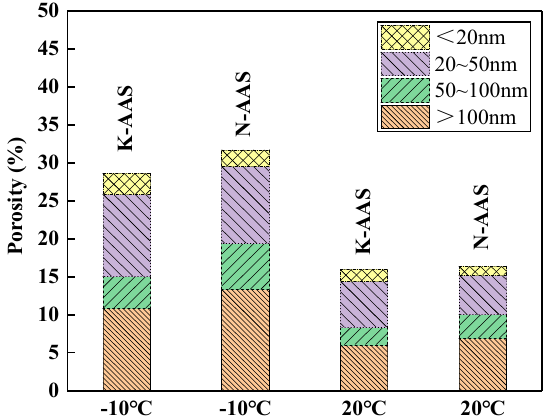
Figure 7. The pore size distribution of K-AAS and N-AAS samples cured for 7 days at temperatures of − 10 °C and 20 °C. of − 10 ◦ C and 20 ◦